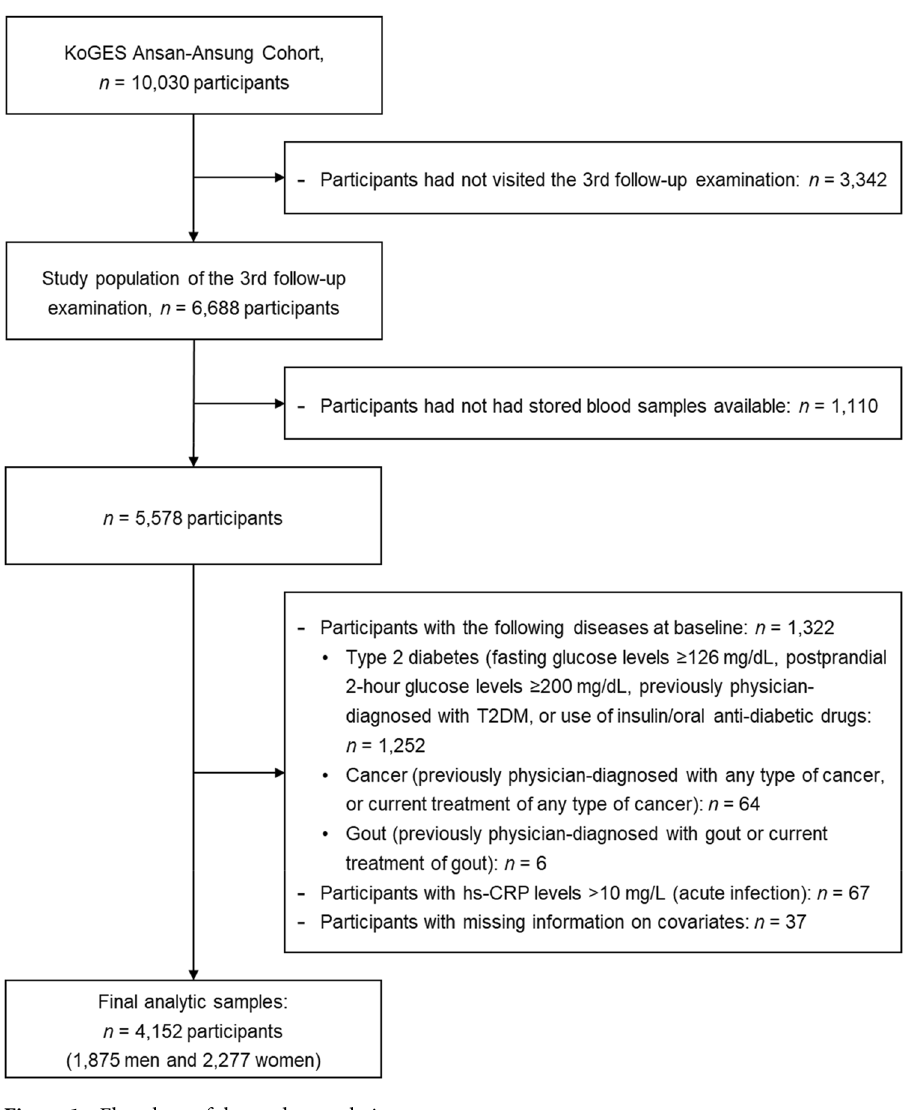
Figure 1. Flowchart of the study